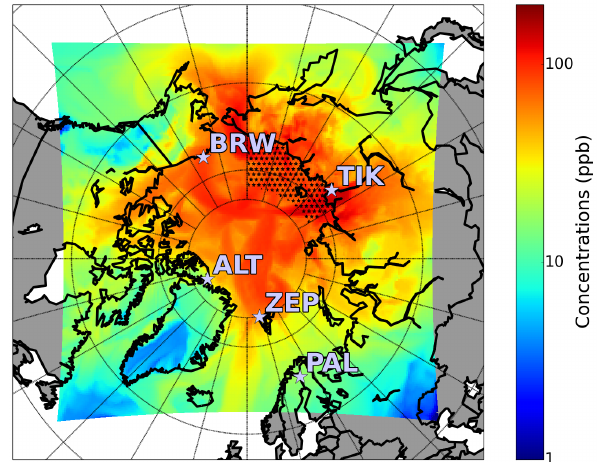
Figure 1. Map of the domain of CHIMERE simulations (see Sect. 2.2) with the area of the ESAS emission (black stars; see Sect. 2.3) and the stations used in the analysis. Shaded colours show the maximum over the whole year 2012 of near-surface simulated influence (in ppb) of the ESAS methane emissions after